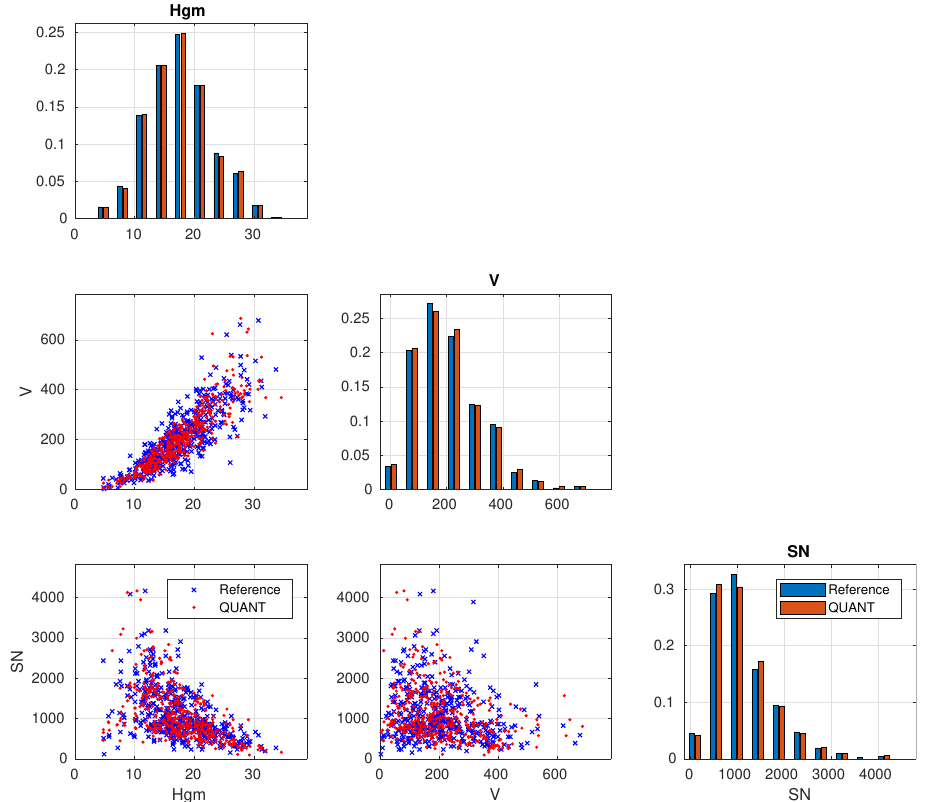
Figure 10. Correlation between the attributes Hgm, V and SN in study site Loppi–Janakkala: the histograms (diagonal panels) and correlations (off-diagonal panels) of the reference set and the QUANT